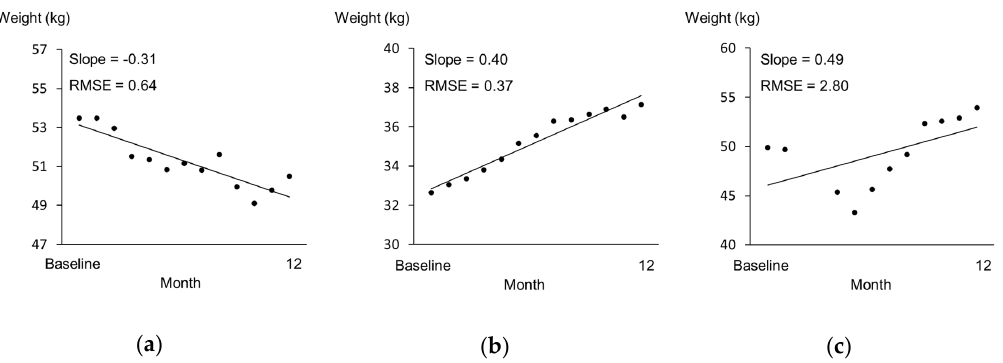
Figure 2. Samples for monthly weight change. The x -axis represents months since baseline, and the y -axis represents weight (kg). ( a ) A subject in the weight loss group. ( b ) A subject in the weight gain group. ( c ) A subject excluded due to their re-entry to the facility after hospitalization in the middle of the follow-up period.